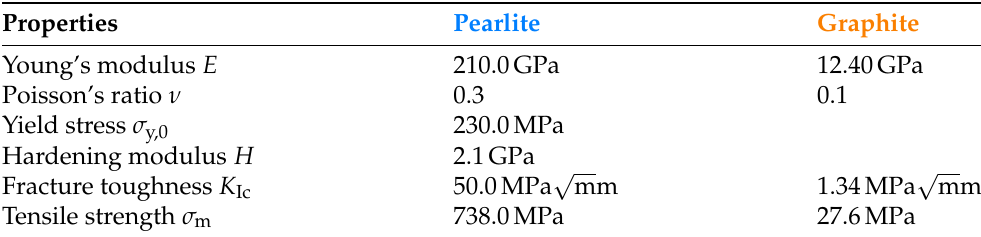
Table 3. Mechanical parameters for pearlite and graphite, used in the